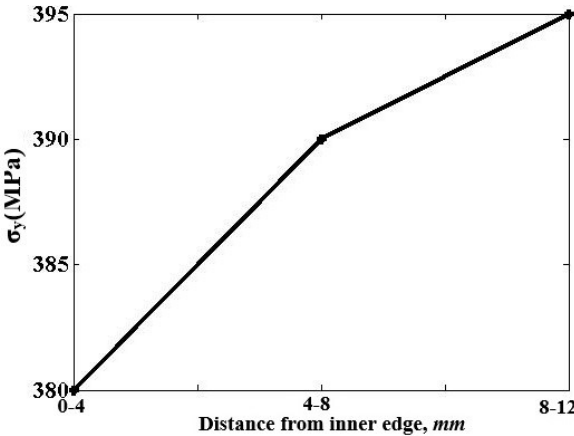
Figure 9: Variation of σ y along the radial direction from inner to outer wall of thick FGM cylindrical shell